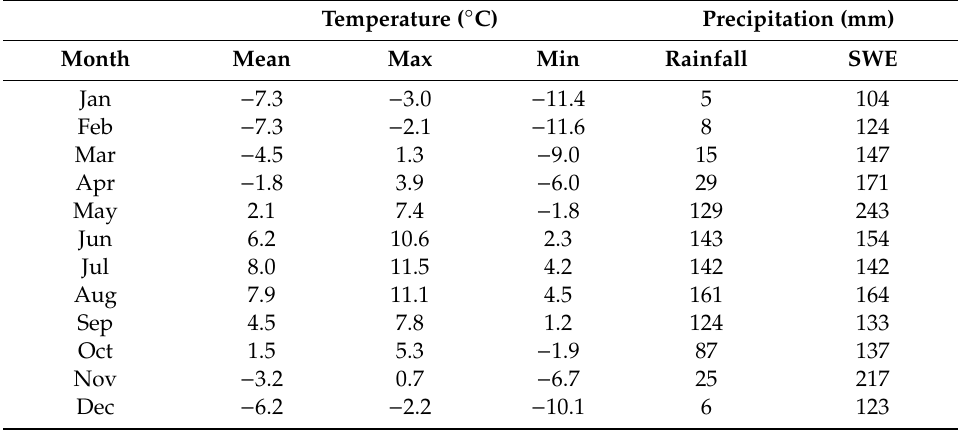
Table 1. Formazza Pian dei Camosci, AWS station. Monthly average values of temperature (mean, minimum, maximum), and precipitation (rainfall, snow water equivalent SWE) registered during